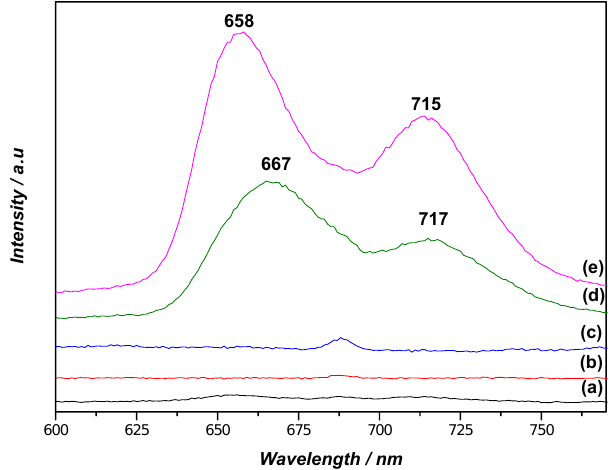
Figure 6. Emission spectra in the solid state of (a) P3 , (b) P4 , (c) TiO 2 , (d) P4-TiO 2 , and (e) P3-TiO 2 .